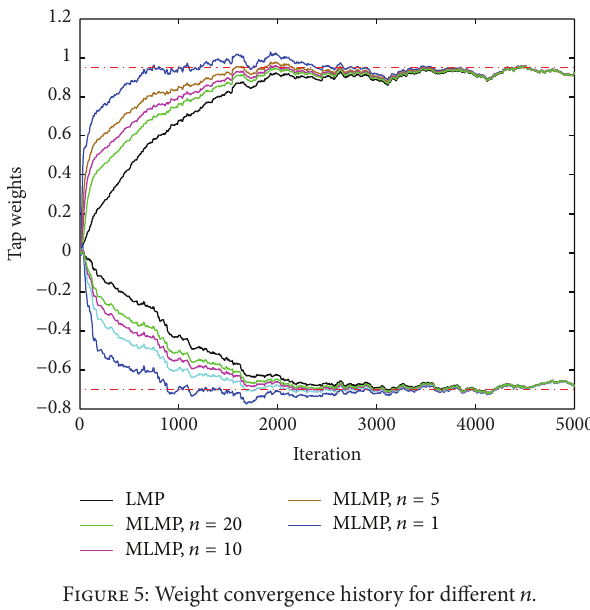
Figure 5: Weight convergence history for different 𝑛 .